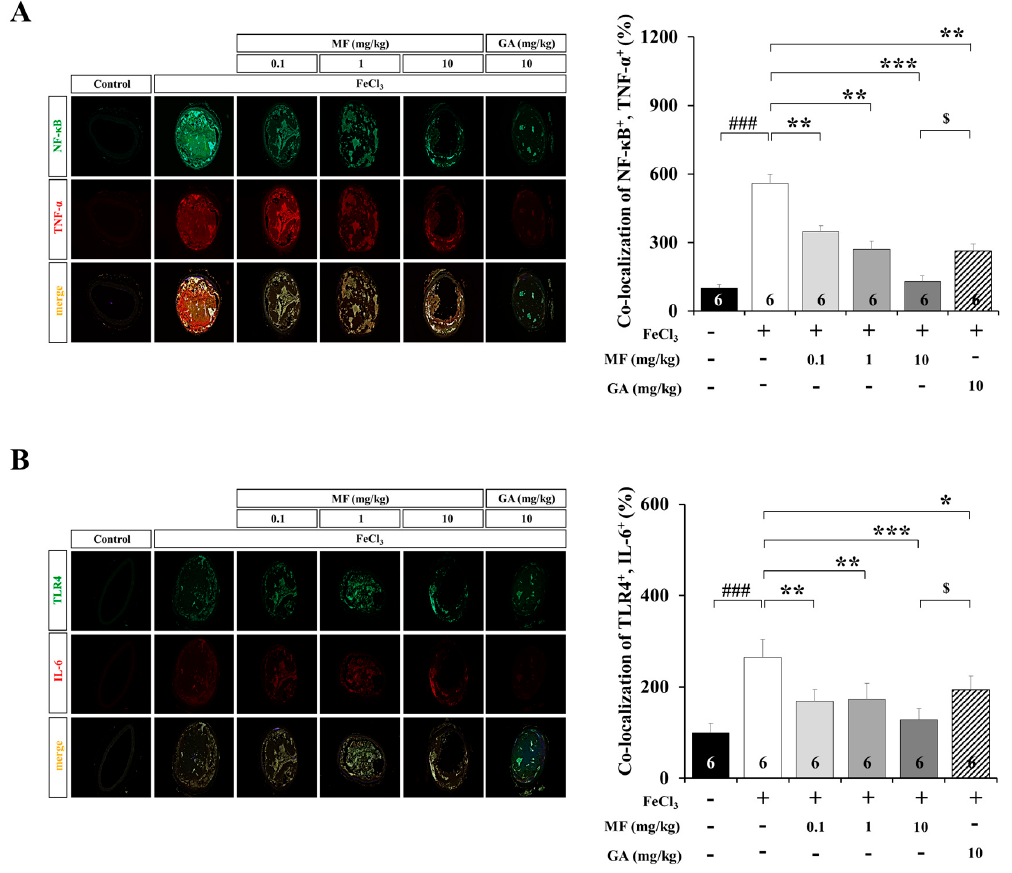
Figure 4. Expression of inflammation-related markers in an FeCl 3 -induced arterial thrombosis model. Images show immunofluorescence staining for NF- κ B (green) and TNF- α (red) with inflammatory signaling marker and inflammatory cytokine co-localization indicated by yellow (merge) ( A ). Images show immunofluorescence staining for TLR4 (green) and IL-6 (red) with inflammatory signaling marker and inflammatory cytokine co-localization indicated by yellow (merge) ( B ). GA was used as a positive Control drug. Data are expressed as mean ± standard deviation. ### p < 0.001, compared with the Control group; * p < 0.05, ** p < 0.01 and *** p < 0.001, compared with the FeCl 3 group; $ p < 0.05, compared with the FeCl 3 + MF 10 mg/kg group; n = 6 rats per group. MF: mumefural; GA: gingkolide A; NF- κ B: nuclear factor- κ B; TNF- α : tumor necrosis factor- α ; TLR4: toll-like receptor4; IL-6: interleukin-6.